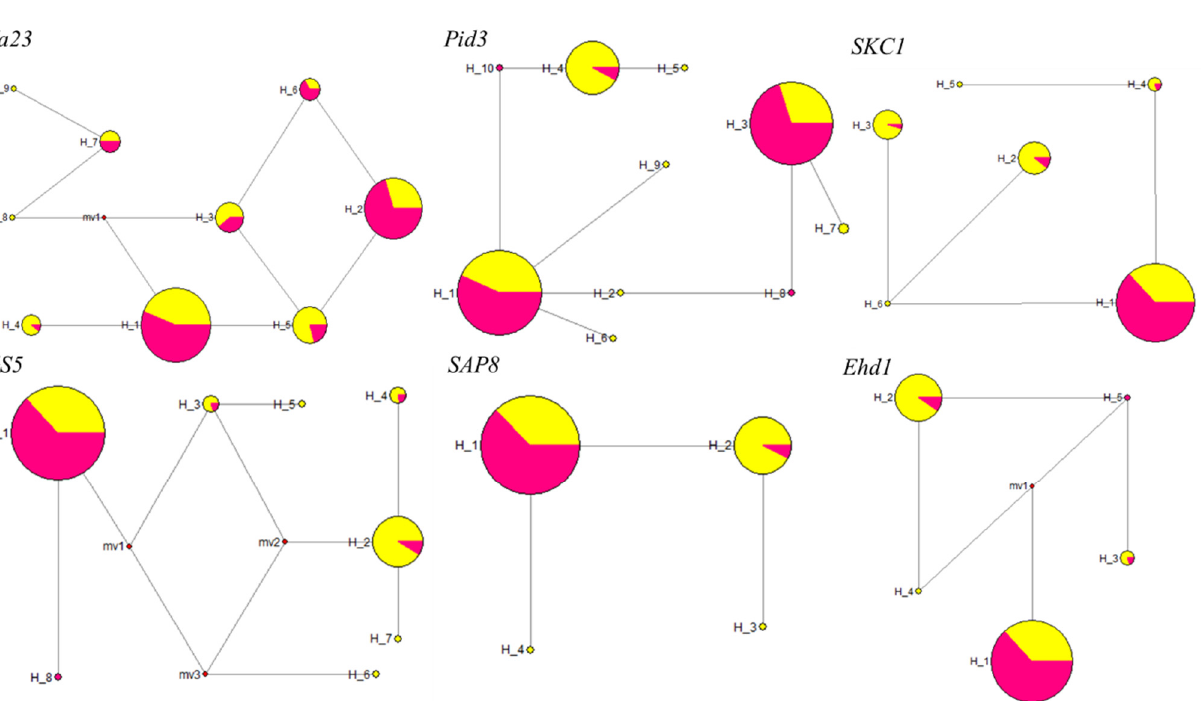
Figure 6. Haplotype networks for six loci in the rice accessions collected in 1980 and 2015. The frequency of the dominant haplotypes also changed between the 1980 and 2015 populations (Figure 7). For most of the dominant haplotypes, such as Hap1 of SKC1 , GS5 , SAP8 , and Ehd1 , the frequency increased to >95% in the 2015 population. In addition,